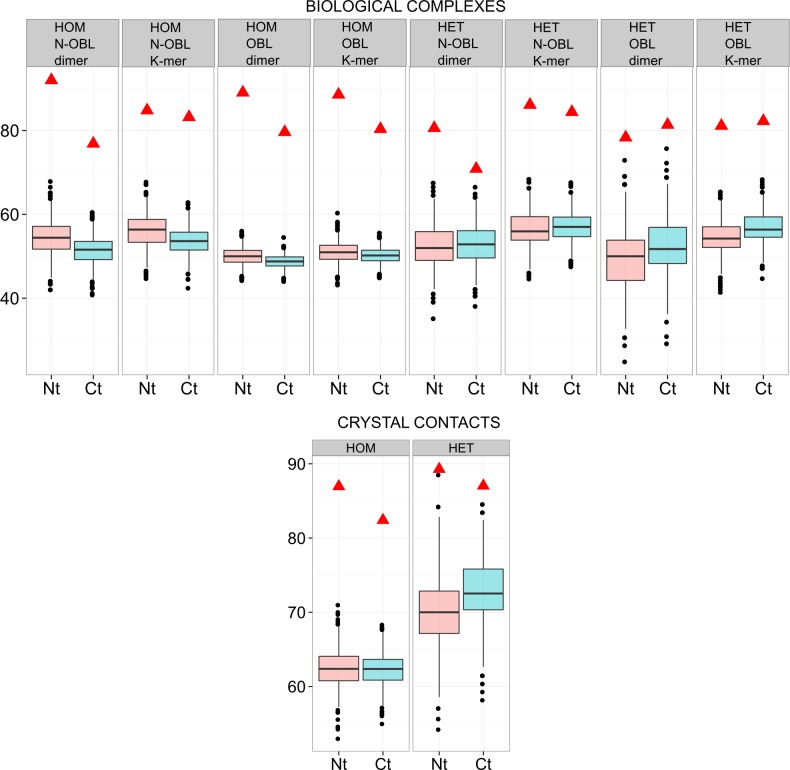
Terminal residues are overrepresented in rim regions in the DIMER70 data set.Each box plot displays the distribution of simulated values of F_rim (fraction of terminal residues in rim regions, among those in interfaces) computed from 1000 random data sets. Box edges correspond to the 25th and 75th percentiles, the notches extend from the 1st to the 99th percentiles, and black points are outliers. Observed fractions are depicted as red triangles. HOM: homo-complexes, HET: hetero-complexes, N-OBL: non-obligate complexes, OBL: obligate complexes. Pink boxes: N-terminal residues, blue boxes: C-terminal residues.